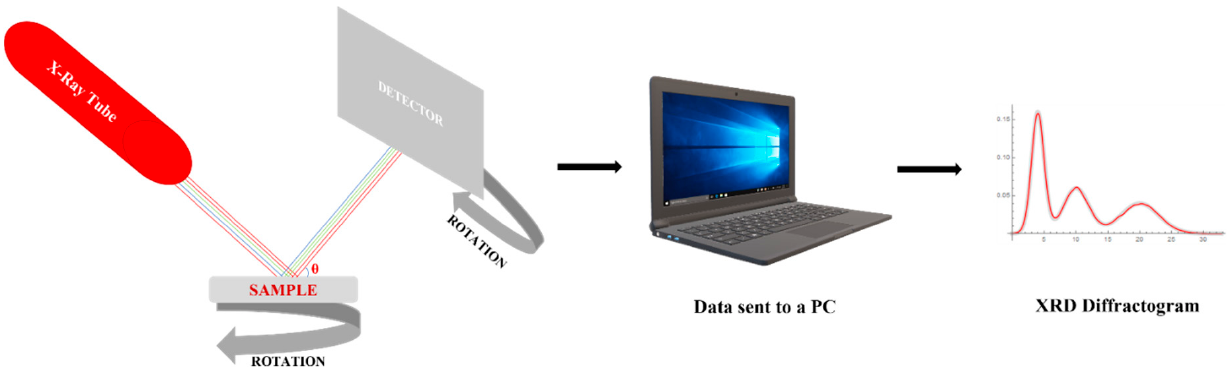
Figure 6. Schematically representation of XRD principle.